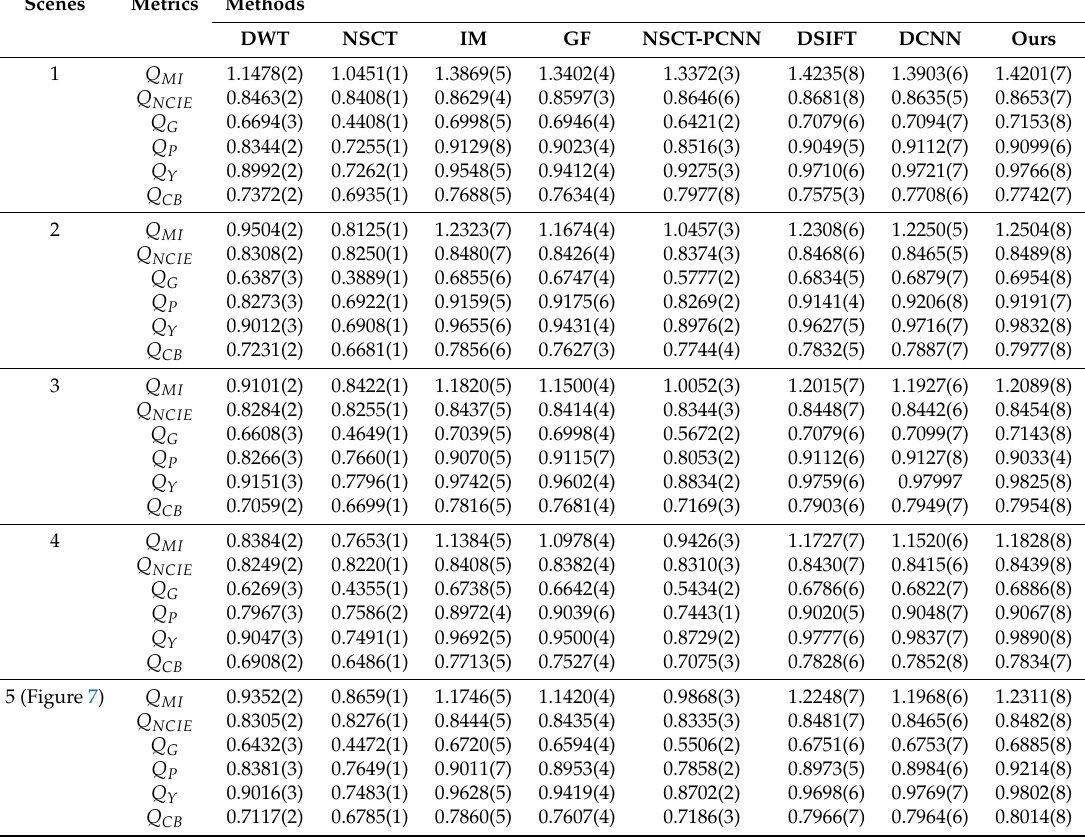
Table 3. Quantitative assessments of the proposed all-in-focus imaging method and other existing multi-focus image fusion methods. Parentheses denote the scores of a method when compared with the other six methods. The higher the score, the better the method. Eight is the highest score, and one is the lowest score. NSCT-PCNN, pulse coupled neural networks in the nonsubsampled contourlet transform